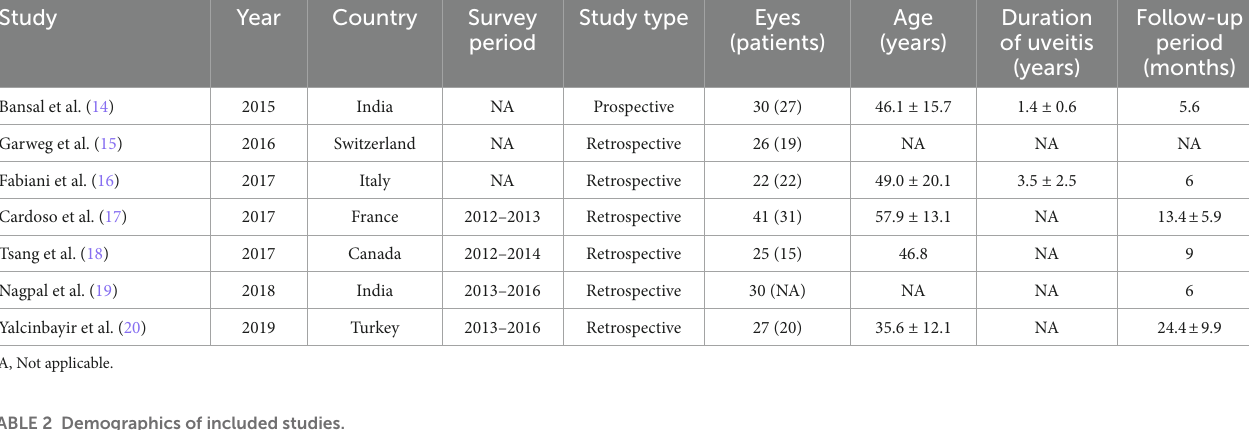
TABLE 2 Demographics of included